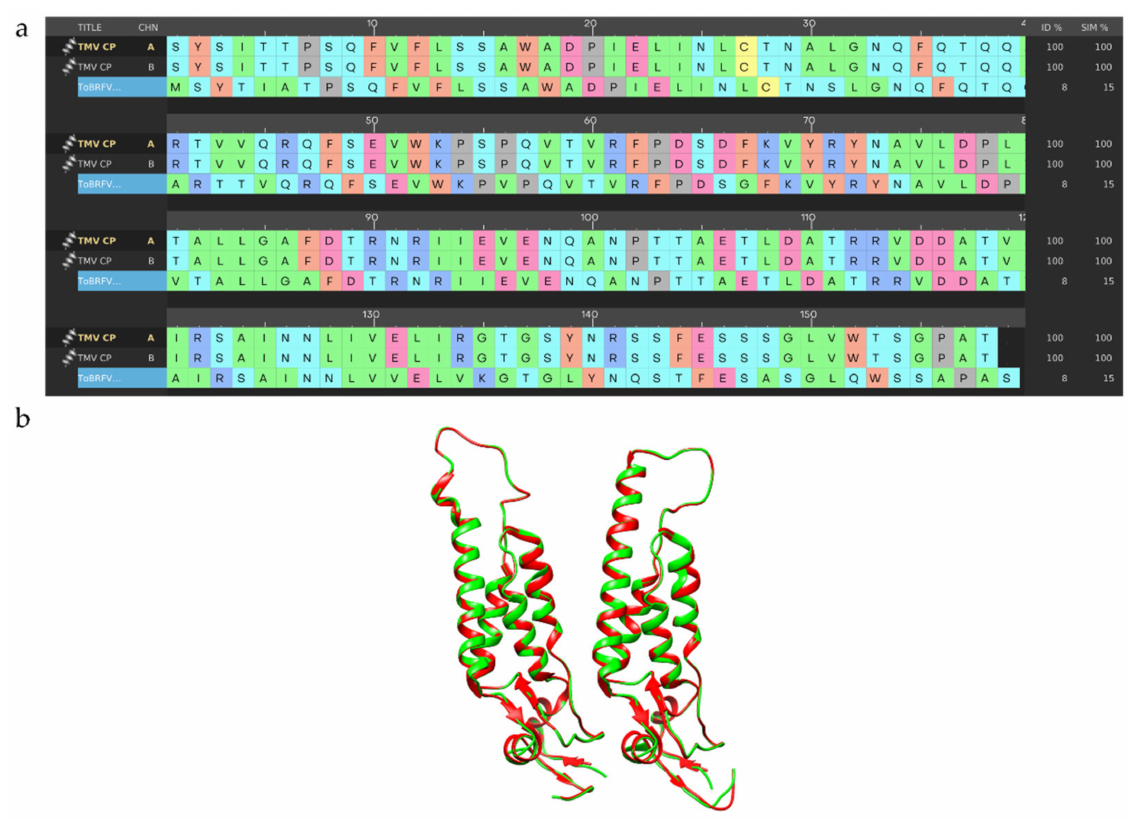
Figure 4. Sequence alignment of CP sequences and homology model of ToBRFV CP; ( a ) Sequences alignment between ToBRFV CP and TMV CP; ( b ) 3D comparison between ToBRFV CP homology model (green) and TMV CP crystal structure (red).